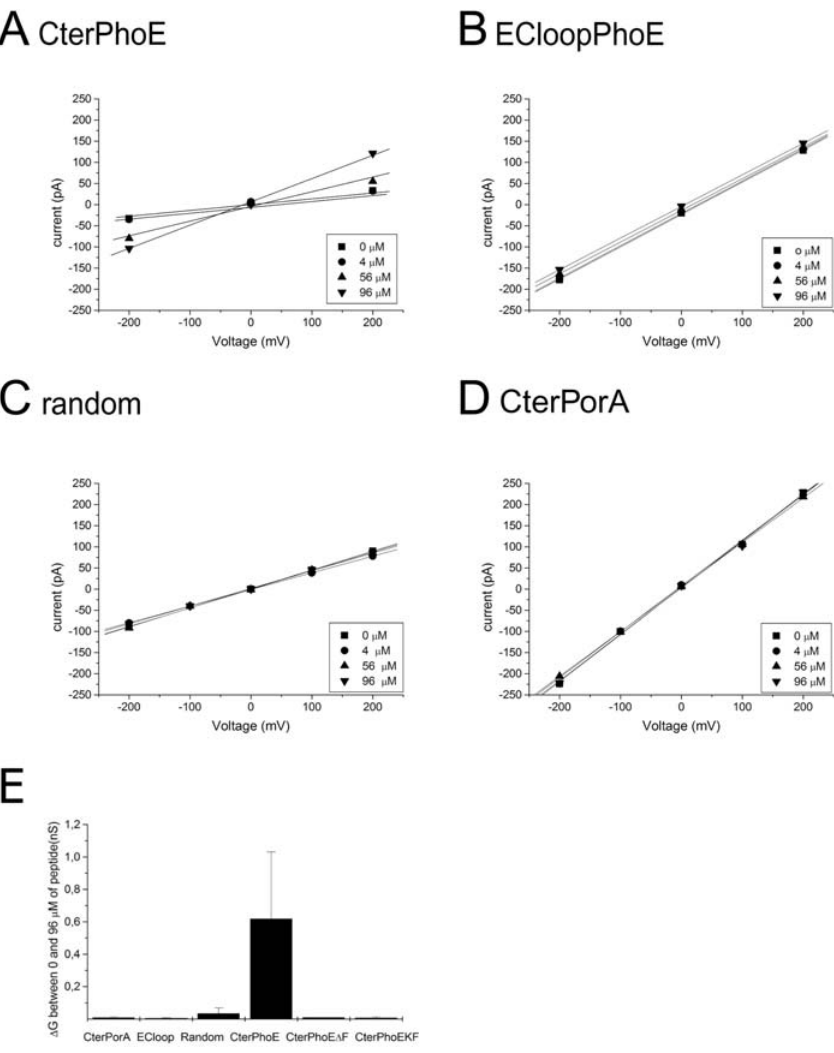
Figure 5. C-Terminal PhoE Peptide Affects Omp85 Pore Activity (A–D) Voltage ramps were applied to bilayers containing Omp85 channels before and after the addition of the peptides shown above the panels. The amounts of peptides added are shown in the inserts. The numbers of active 0.12-nS Omp85 channels in the experiments depicted were 1, 6, 4, and 9, in (A), (B), (C), and (D), respectively. (E) Increase in conductivity per Omp85 channel upon addition of 96 l M of each peptide. Each experiment was repeated at least four times. DOI: